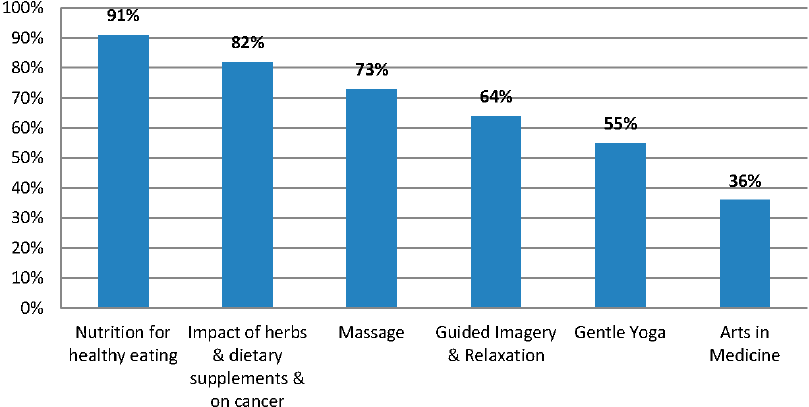
Figure 1. The four presentation topics were selected from six possible topics, based on pretest scores for interest level per topic. The two lower-scoring items, gentle yoga and arts in medicine, were thus not selected.